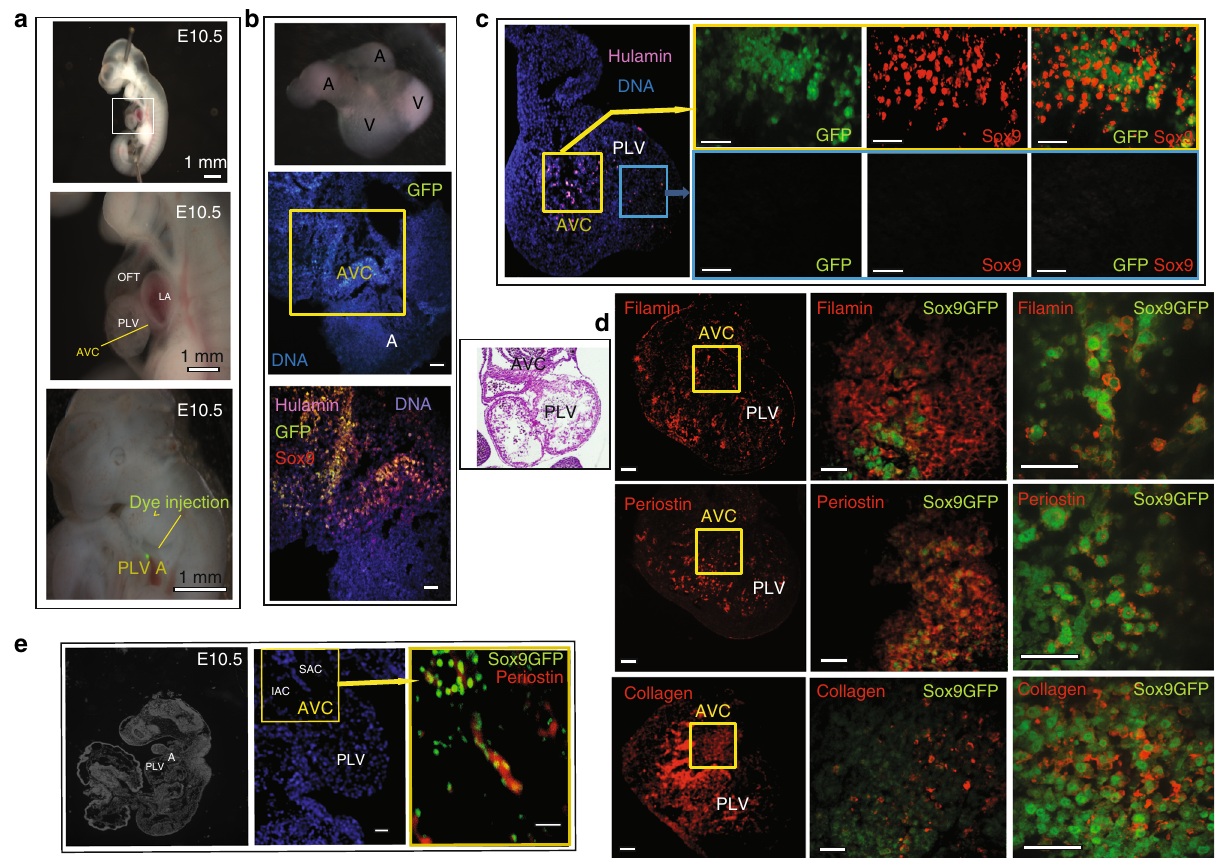
Fig. 4 In vivo differentiation of HPVCs in mouse embryonic heart. SSEA1 + MESP1 + Sox9GFP cells were sorted and treated with VEGF/FGF8 for 7 days before injection into E10.5 mouse AVC. a An E10.5 embryo is stretched to expose the AVC. Dye injection shows the target of the injection. Scale bars are 1 mm. b Two hours after injection the hearts were dissected and placed in culture for two days on Matrigel coated inserts (top inset). The heart sections were immunostained with anti-human LmnA/C, – GFP, and – Sox9 antibodies. c Two sites of injection and resulting cell fate. Cells were injected into the AVC or the chamber. Only the cells injected into the AVC (visualized on the eosin/hematoxylin stained heart section in the inset) underwent EMT and expressed Sox9-GFP. d , e Sox9GFP VEGF/FGF8-treated cells were injected into the AVC and the hearts were cultured for two days ( d ) or the whole embryos were cultured in their yolk sac for 36 h ( e ).The heart sections were stained with anti- fi laminA, -periostin or – collagen antibodies. The middle panels in ( d ) show the AVC region and the right panels a high magni fi cation of a subset of cells within the AVC ( e ). A section of the whole embryo is shown in the left panel; the middle and right panels show the heart and the cells injected in the AVC. The heart sections were stained with anti-periostin antibody. Results are representative of at least 9 experiments. SAC superior AV cushions, IAC inferior AV cushions, PLV primary left ventricle, A atrium. The scale bars in b-e indicate 50 μ